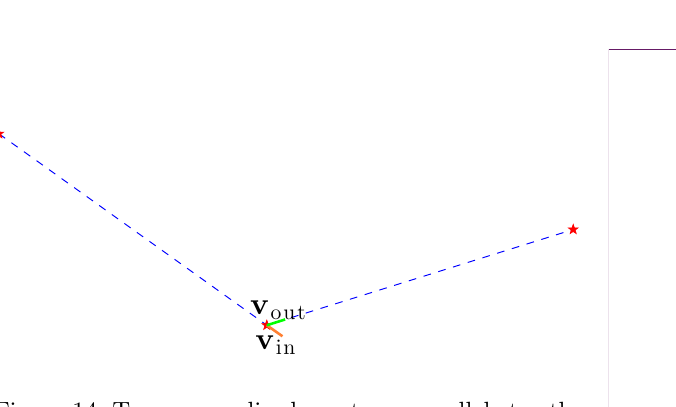
Figure 14: Two normalized vectors parallel to the straight lines are defined